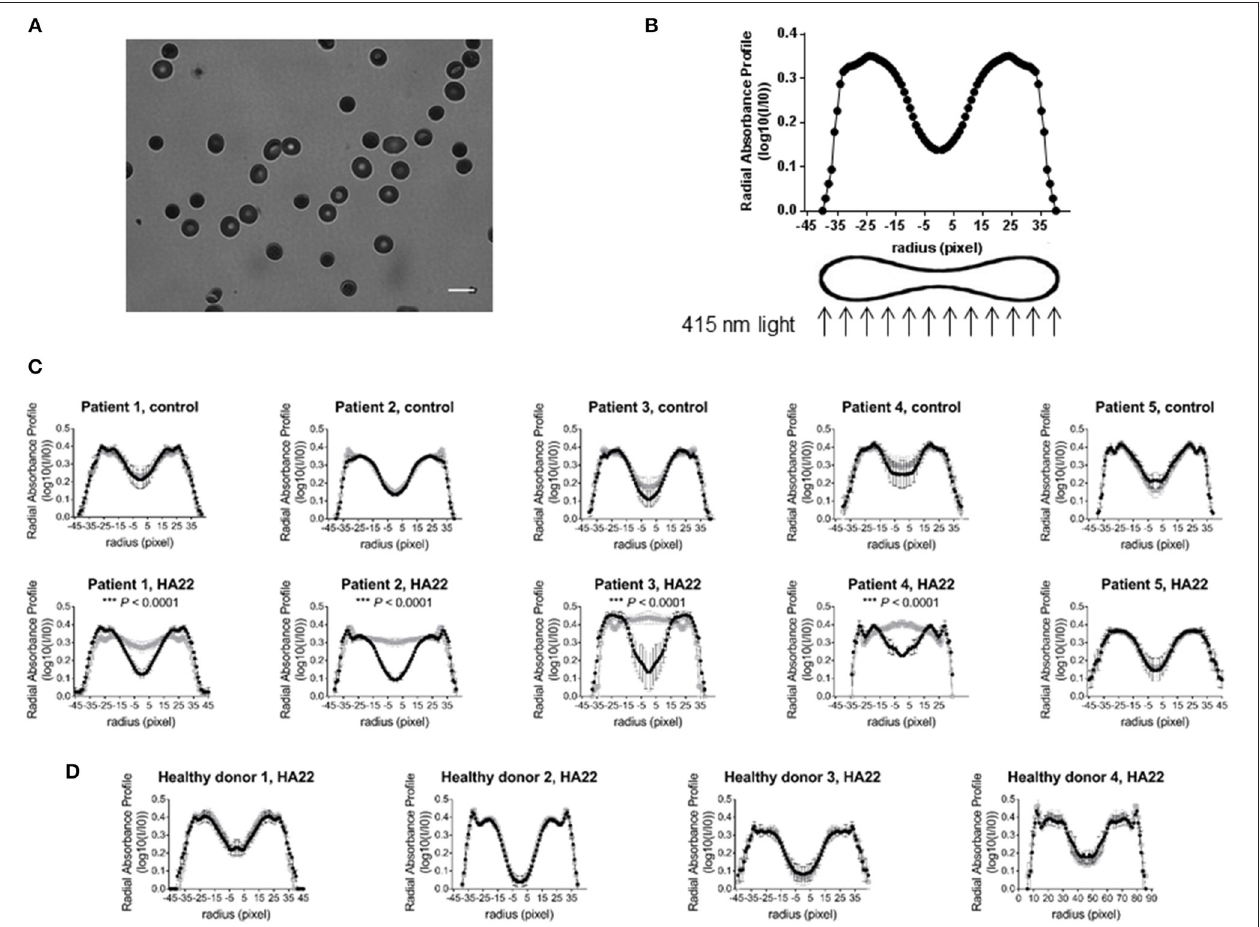
FIGURE 2 | CAT-8015-induced changes in RBC morphology. (A) Representative image of RBCs from a pediatric ALL patient exposed to 415nm light at room temperature in DPBS/BSA buffer. The light regions indicate low absorption of light, while the dark regions indicate high absorption of light. Bar represents 10 µ m. (B) Representative radial profile of a RBC with a discoid shape. To mimic the shape of RBCs, we plotted the radial absorbance profile of individual cells within each population and mirrored this dataset on the y axis. (C) Average radial profiles of RBCs from pediatric ALL patients ( n = 5) before (in black) and after (in gray) treatment with buffer only (top row), or before (in black) and after (in gray) treatment with buffer containing CAT-8015 (bottom row). (D) Average radial profiles of RBCs from healthy donors ( n = 4) before (in black) and after (in gray) treatment with buffer containing CAT-8015. Statistical significance was determined using multiple t tests. Significant (*** P < 0.0001) morphological changes in the center of the cell (radius (pixels) − 5-5) were evident in ALL patients 1–4 after treatment with CAT-8015. At least 10 cells per treatment were analyzed.